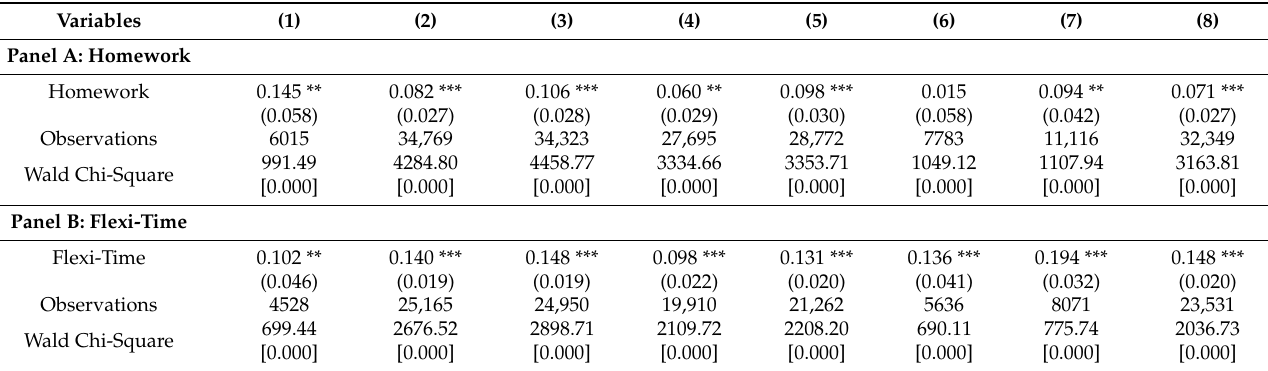
Table 5. Homework, Flexi-Time and Job Satisfaction for Workers with Disabilities and Health